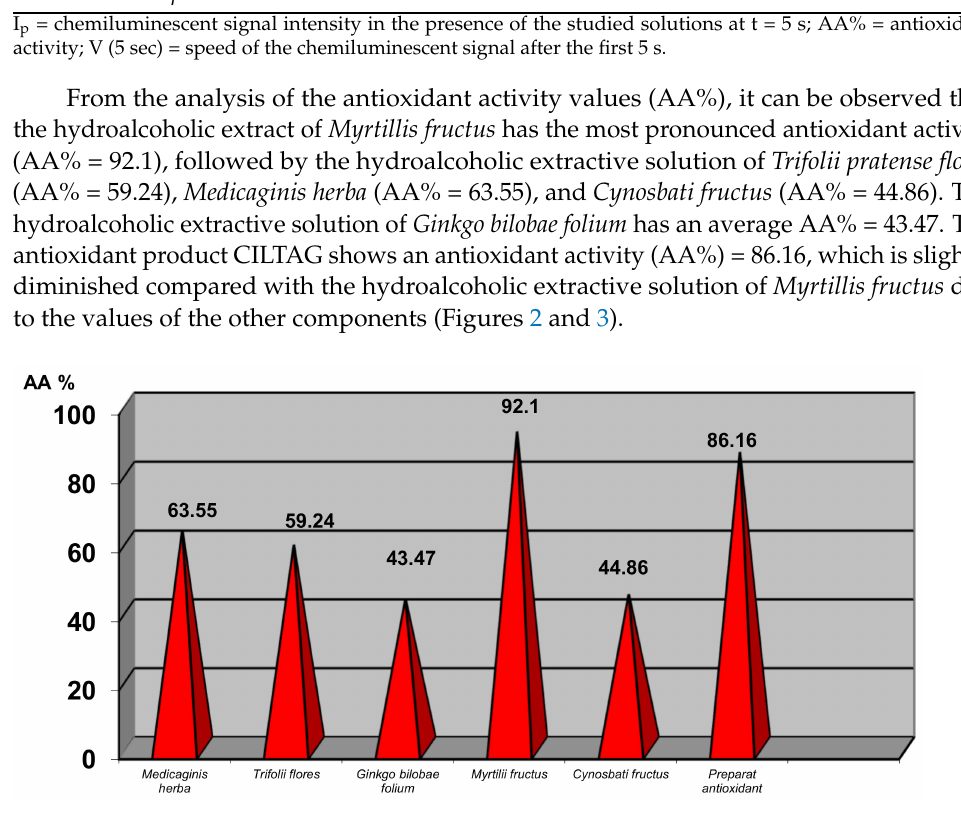
Figure 2. Comparative histogram of the antioxidant activity values of the studied